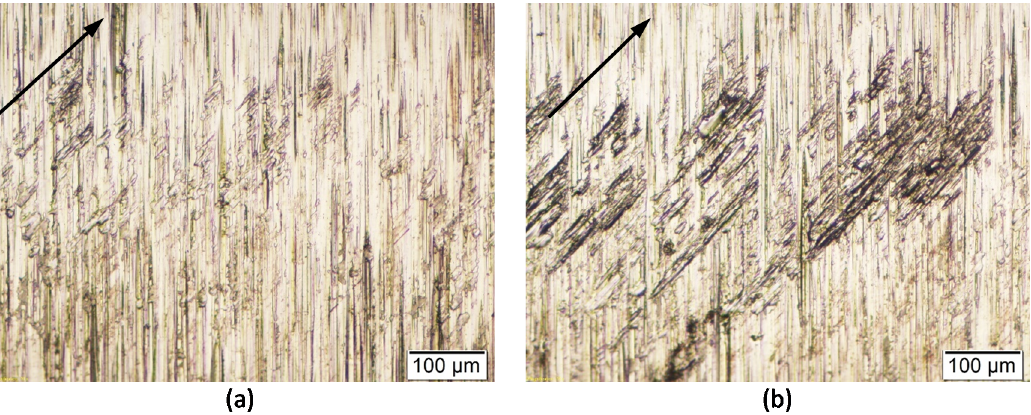
Figure 7. Galling test results for SIHARD S250 steel sliding against soft annealed low-C steel: ( a ) galling initiation and ( b ) transfer layer build-up (arrows indicate sliding direction).